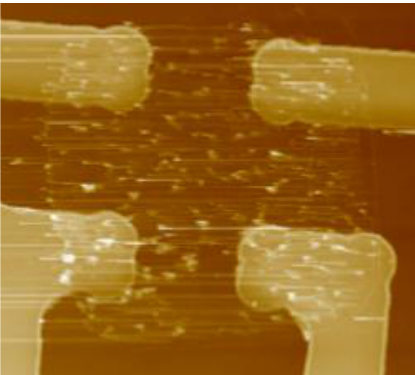
( c ) The AFM characterization of sensor surface ’ s active area after graphene transfer process and functionalization between the source and drain electrode.